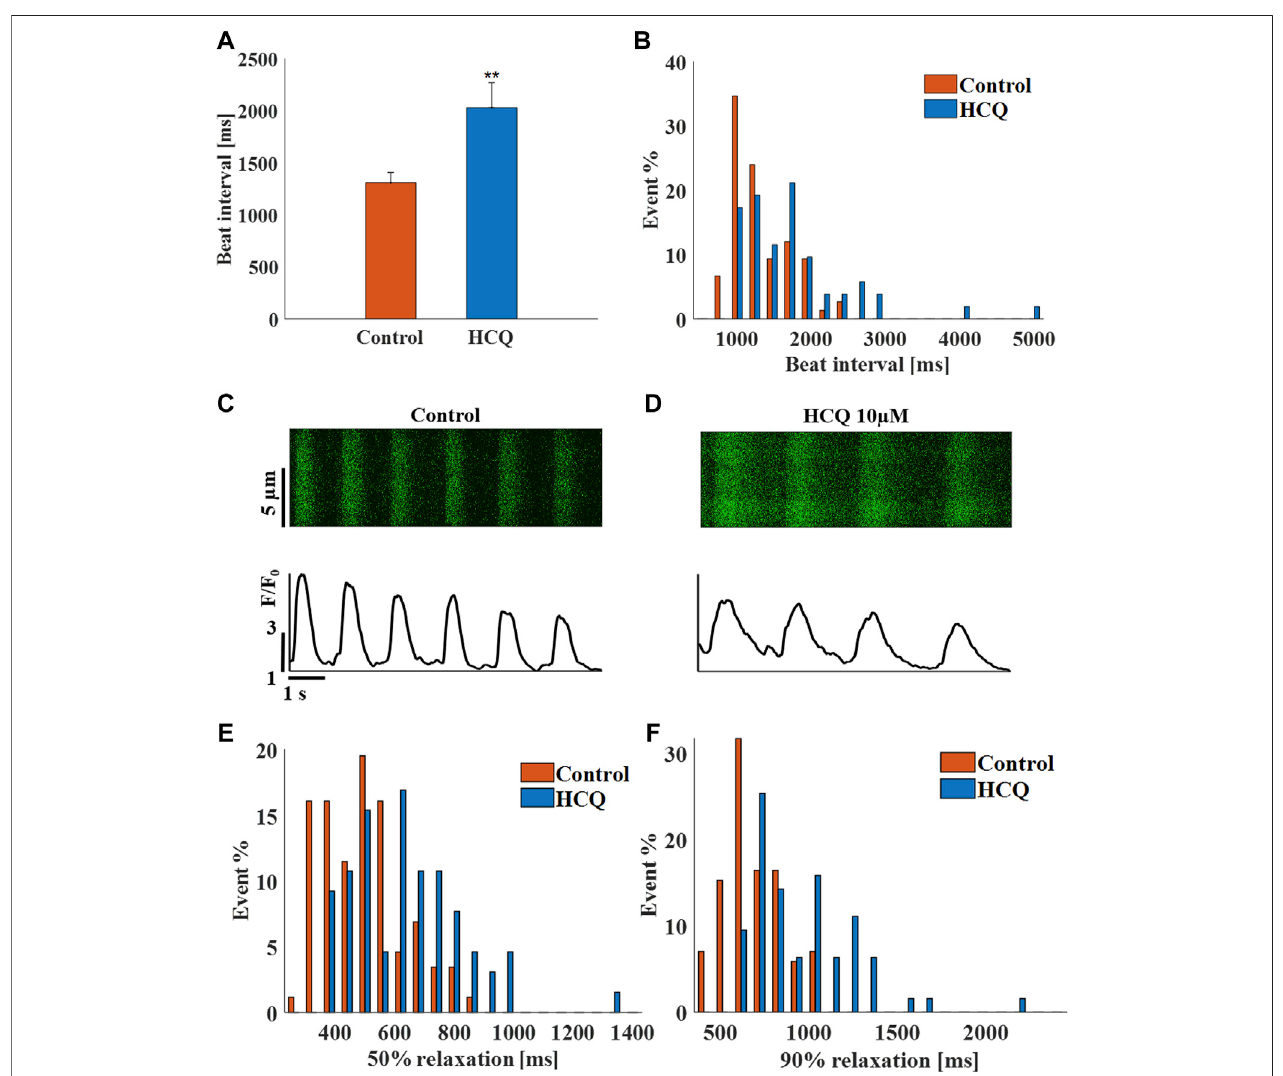
FIGURE3| Theeffectofhydroxychloroquine(HCQ)onhumaninducedpluripotentstemcell-derivedcardiomyocytes(iPSC-CM). (A) Meanbeatingintervaland (B) beat interval distribution of control and human induced pluripotent stem cell-derived cardiomyocytes (iPSC-CM) treated with 10 μ M HCQ ( n = 18). Representative Ca 2+ transients in (C) control and in (D) 10 μ M HCQ-treated iPSC-CMs. The distribution of (E) 50% and (F) 90% Ca 2+ transient relaxation time in control and in 10 μ M HCQ- treated iPSC-CMs. ** p < 0.01 vs. control.